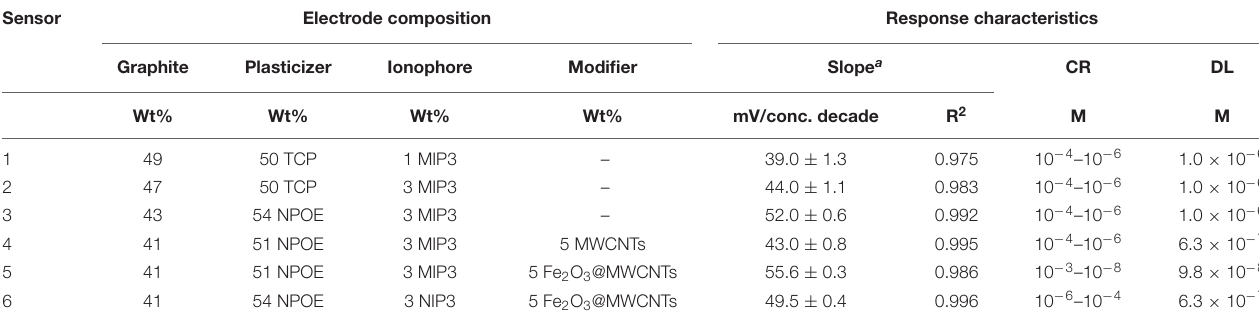
TABLE 2 | Effect of the carbon paste electrode composition on the response characteristics: slope concentration range (CR) and detection limit (DL). Sensor Electrode composition Response characteristics Graphite